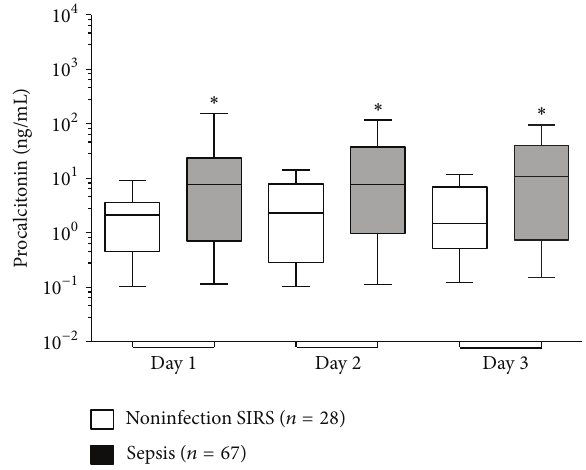
Figure 1: Daily concentration of PCT in sepsis and noninfectious SIRS. Boxes show the median and interquartile range, whiskers show 10–90th percentiles. ∗ Mann-Whitney test between sepsis and noninfectious SIRS for procalcitonin, 𝑃 = 0.02 (days 1 and 2) and 𝑃 = 0.03 (day